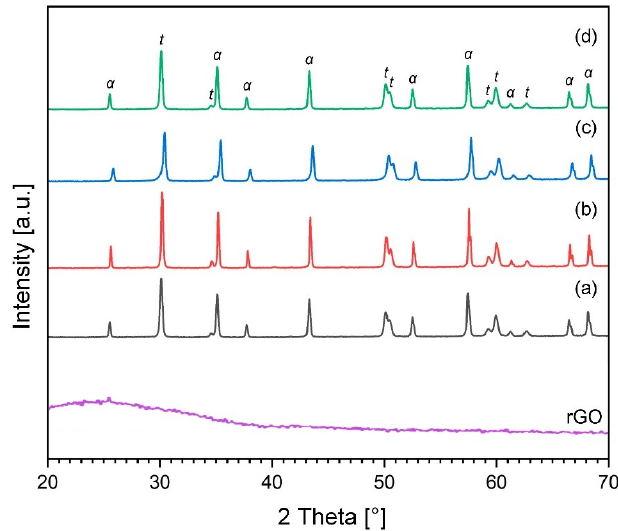
Figure 2. XRD analysis of rGO and sintered ZTA-GO composites containing 0 wt.% GO (a); 0.28 wt.% GO (b); 0.52 wt.% GO (c) and 6.1 wt.% GO (d). “ α ” and “ t ” denote corundum and tetragonal ZrO 2 , respectively.